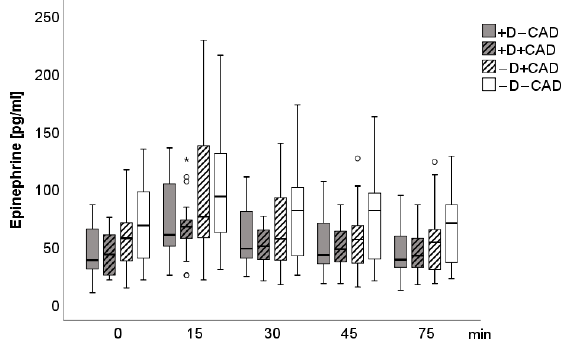
Figure 1. Boxplot of epinephrine for each measurement time. Circle: ordinary outliner defined as one and a half boxlength, asterisk: extreme outliner defined as above one and a half to threefold boxlength.